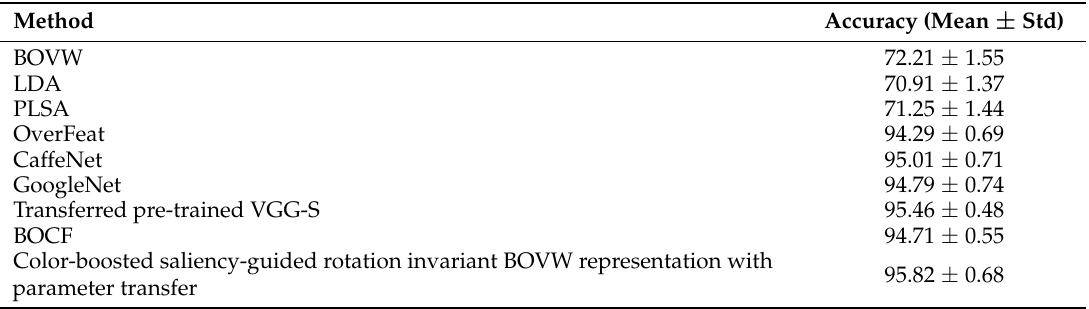
Table 2. Comparison with state-of-the-art methods in the WHU-RS dataset.